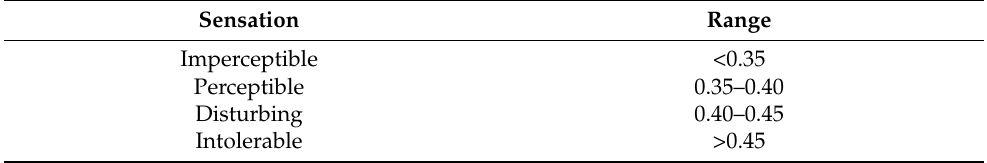
Table 8. Glare rating of DGP (based on